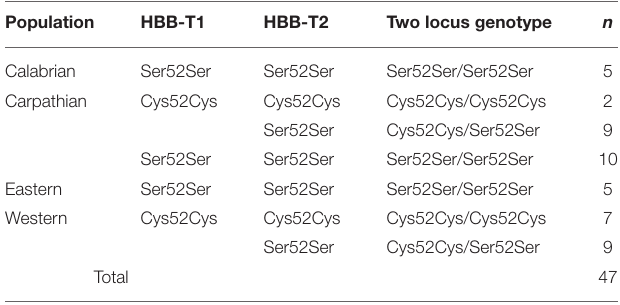
TABLE 1 | Numbers of voles analyzed from each population (mtDNA clade) and HBB-T1 and HBB-T2 genotype.